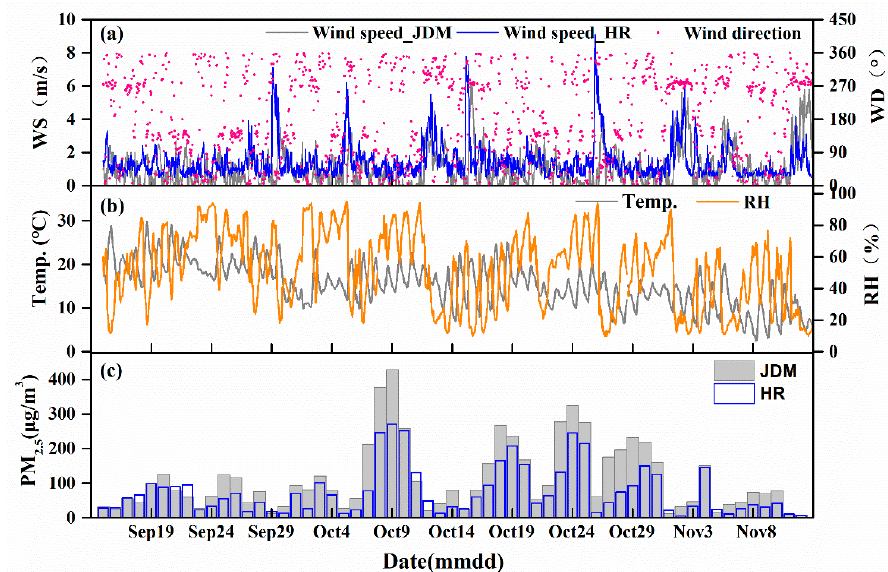
Figure 1. ( a , b ) Meteorological conditions and ( c ) PM 2.5 mass concentration during the sampling period at the Beijing urban site (JDM) and suburban site (HR). Table 1. PM 2.5 mass concentrations and meteorological parameters before and during the